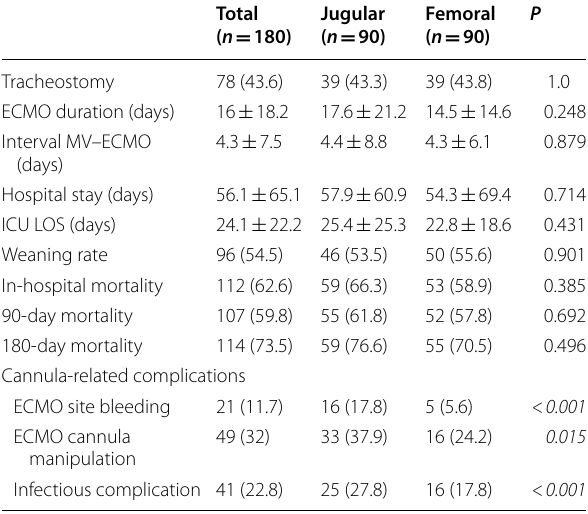
Values are expressed as mean standard deviation, or n (%); significant P values ± are in italic ECMO extracorporeal membrane oxygenation, MV mechanical ventilation, ICU LOS length of stay in intensive care unit